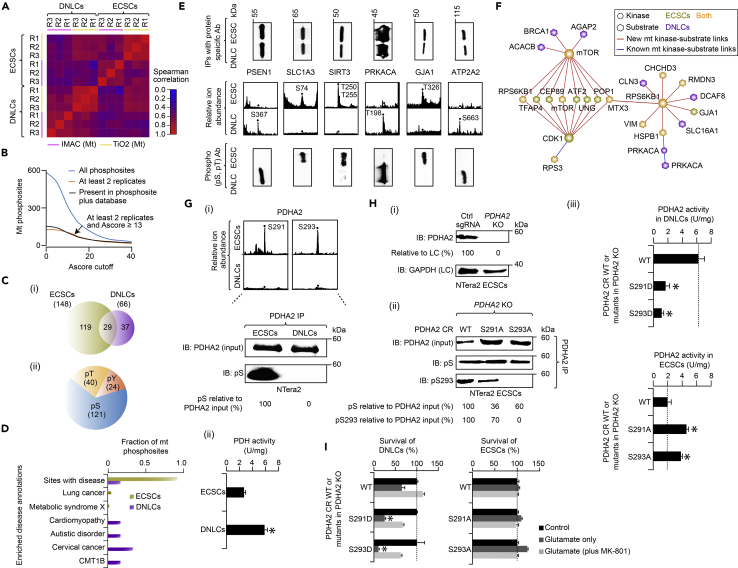
Identification of Phosphorylation Sites in ECSCs and DNLCs(A) Spearman correlation profiles clustered between phosphoproteome replicate experiments (using peptide counts for each phosphorylation site) from the mt extracts of ECSCs and DNLCs using the indicated phosphopeptide enrichment methods.(B) mt phosphosites in each cell state with various Ascore cutoff and replicate measurements.(C) Phosphosites specific or common to each cell state (i) and their localization (ii) on serine (pS), threonine (pT), and tyrosine (pY) residues.(D) Enrichment of all phosphosites and those associated with human diseases (few representative ones highlighted); false discovery rate (Benjamini-Hochberg correction)-adjusted p value (or Q-value) of the Fisher's exact test.(E) Relative ion abundance for proteins indicated with cell state-specific phosphosites were immunoprecipitated and probed with protein-specific and phospho (pS, pT) antibodies.(F) Kinase-substrate phosphorylation network (Table S4) in ECSCs and/or DNLCs is indicated with mt kinases (circle) and their mt substrates (hexagonal).(G) Relative ion abundance of PDHA2 phosphosites in ECSCs, and immunoprecipitates of PDHA2 immunoblotted (IB) with pS antibody (i). Band intensities normalized to PDHA2. PDH activity (ii) measured after 60 min of incubation with mt extracts from ECSCs or DNLCs.(H) PDHA2 (i) and pS or pS293 (ii) levels measured in control (ctrl) single-guide RNA (sgRNA) and PDHA2 KO ECSCs, or in the immunoprecipitates of PDHA2 KO ECSCs complemented with wild-type (WT) CRISPR-resistant (CR) copy of PDHA2 and non-phosphorylatable mutants using anti-PDHA2 antibody were IB with indicated antibodies. Band intensities normalized to PDHA2. Activity of PDHA2 (iii) is shown after 60 min of incubation with the mt extracts of WT or PDHA2 phosphomimetic and non-phosphorylatable mutants from DNLCs and ECSCs, respectively.(I) Survival of PDHA2 mutants and WT ECSCs or DNLCs in control salt solution, glutamate (1 mM), or glutamate plus MK-801 (300 nM). Data for (G, H, and I) are mean ± SD (n = 3 biological replicates; *p ≤ 0.05 by Student's t test).See also Table S4.